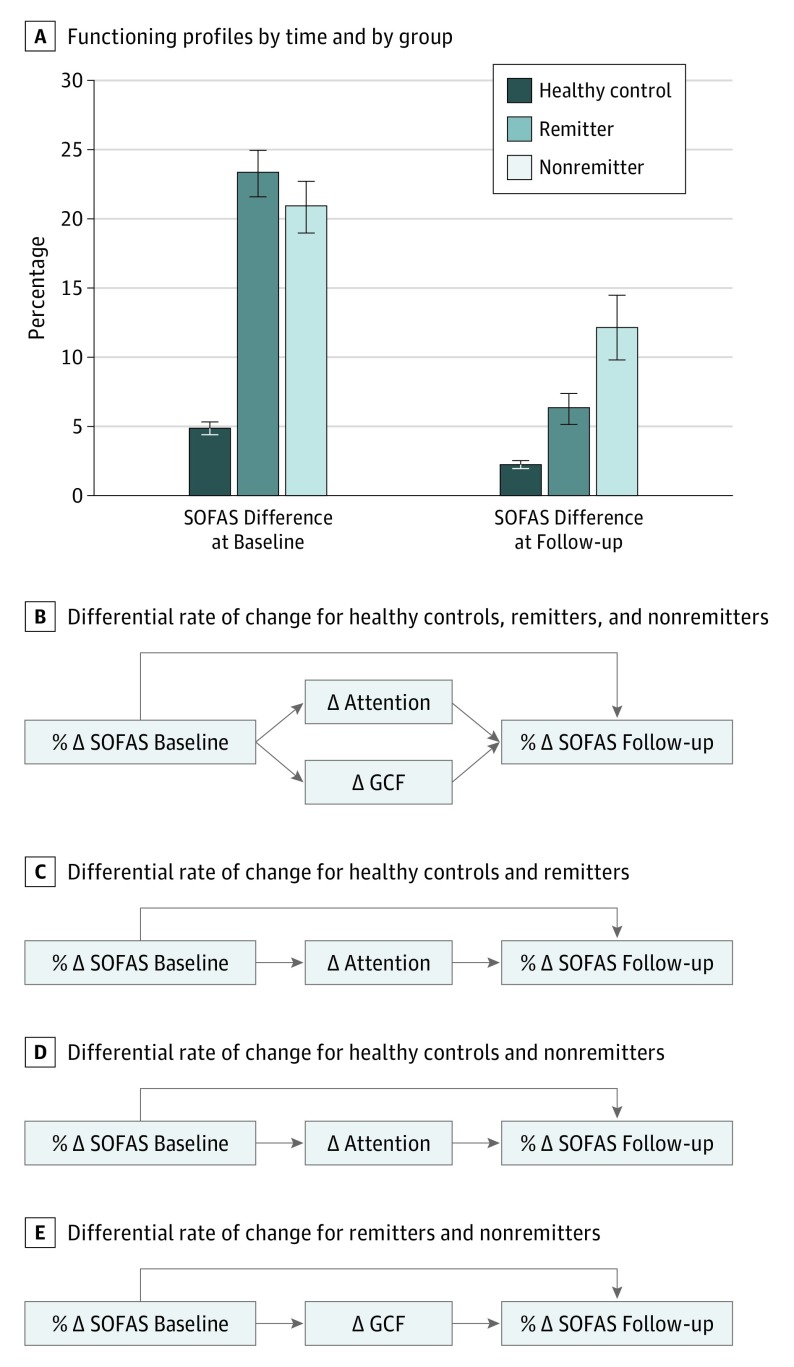
Social and Occupational Functioning and Cognitive Component ChangesA, Functioning profiles by time point and group (healthy controls, remitters, and
nonremitters). B, Repeated-measures schematics for time-by-group and time-by-cognitive
component. Differential rate of change between baseline and follow-up: SOFAS:
F = 36.85; P < .001;
η2 = 0.130. Attention component:
F = 5.65; P = .02;
η2 = 0.013. GCF component:
F = 7.18; P = .01;
η2 = 0.014. C, Post hoc repeated measures. Differential
rate of change between baseline and follow-up: SOFAS:
F = 90.86; P < .001;
η2 = 0.170. Attention component:
F = 5.65; P = .02;
η2 = 0.013. D, Post hoc repeated measures. Differential
rate of change between baseline and follow-up: SOFAS:
F = 8.67; P = .003;
η2 = 0.020. Attention component:
F = 15.83; P < .001;
η2 = 0.036. E, Post hoc repeated measures. Differential
rate of change between baseline and follow-up: SOFAS:
F = 3.24; P = .07;
η2 = 0.002. GCF component:
F = 7.11; P < .009;
η2 = 0.058. % indicates percentage difference between
best and worst functioning during assessment time point; ∆, difference between
baseline and follow-up; GCF, general cognitive function; and SOFAS, Social and
Occupational Functioning Assessment Scale.